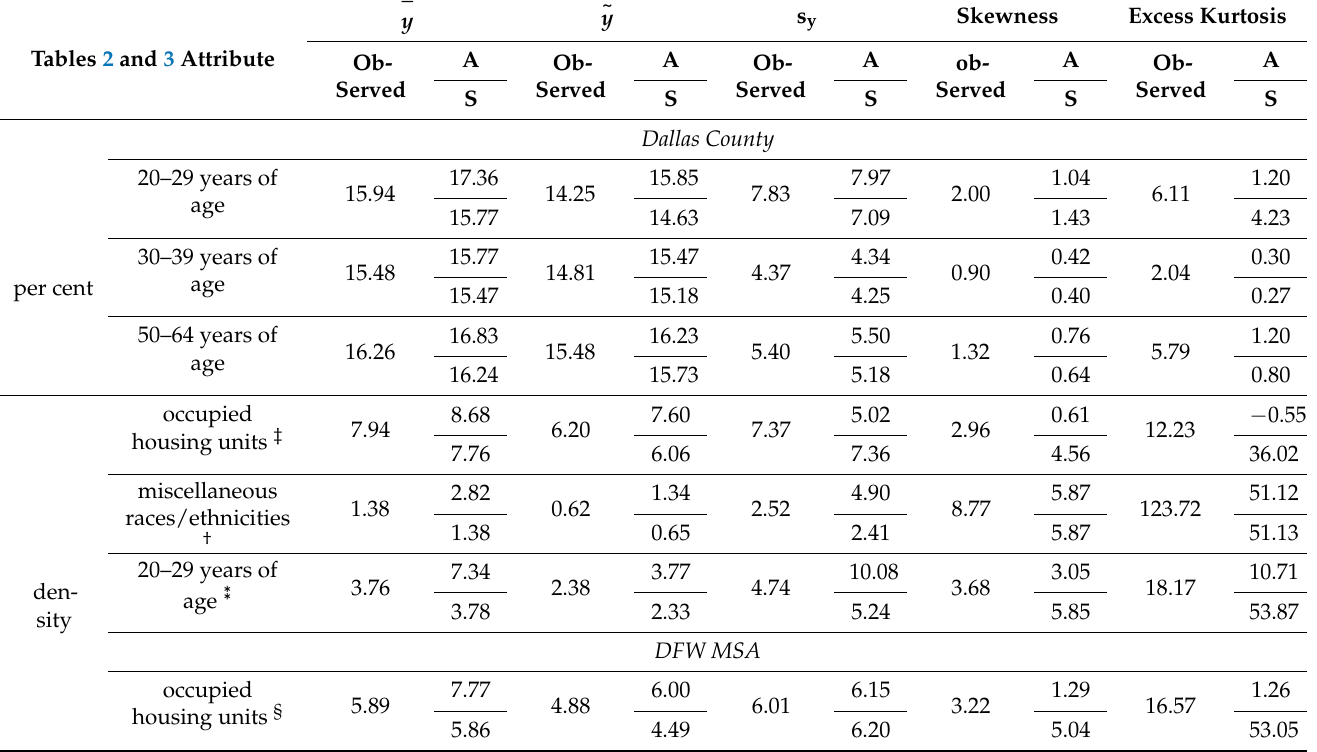
Table 8. Summary statistics calculated with complete dataset back-transformations.